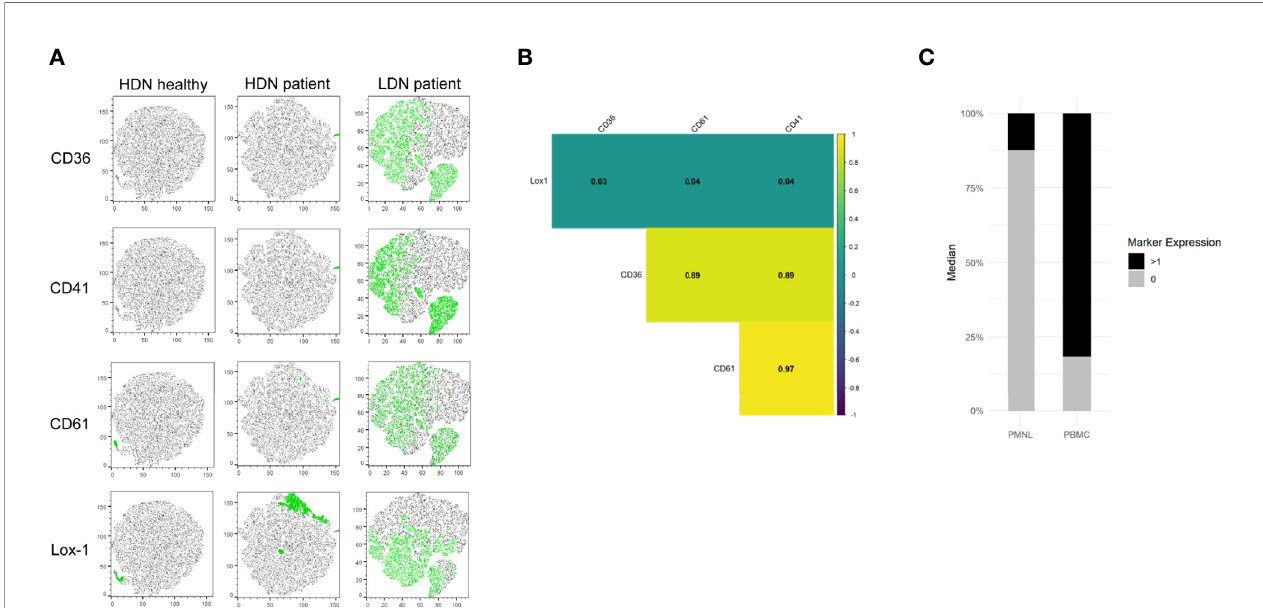
FIGURE 5 | CD36, CD41, CD61 and Lox-1 are co-expressed in LDNs from NSCLC patients. (A) Representative tSNE visualization of HDNs and LDNs demonstrates almost absent expression of CD36, CD41, CD61 and Lox-1 in HDNs from healthy donors and NSCLC patients while a heterogeneous expression of the markers was detected in LDNs from NSCLC patients. (B) Correlation analysis of the expression of the four studied markers indicating no correlation of Lox-1 with the rest of the markers and high correlation between CD36, CD41 and CD61 in one representative patient. (all results statistically signi fi cant/p<0.01). (C) Proportions of positive marker expression (black) and negative marker expression (grey) in the PMNL and PBMC fractions of NSCLC